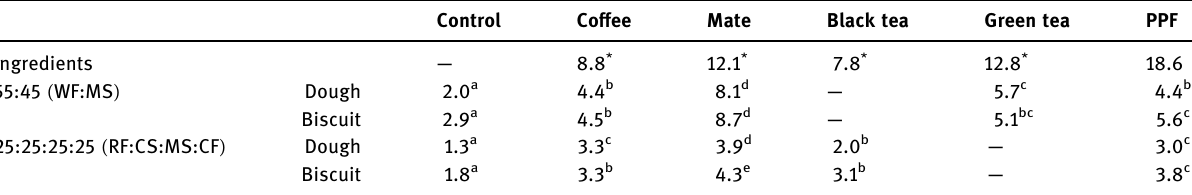
Table 7: FRAP results in samples prepared with 55:45 wheat fl our:maize starch ( WF:MS ) blend or with 25:25:25:25 rice fl our:cassava starch:maize starch:chickpea fl our ( RF:CS:MS:CF ) blend with infusions or Prosopis chilensis pod fl our ( PPF )